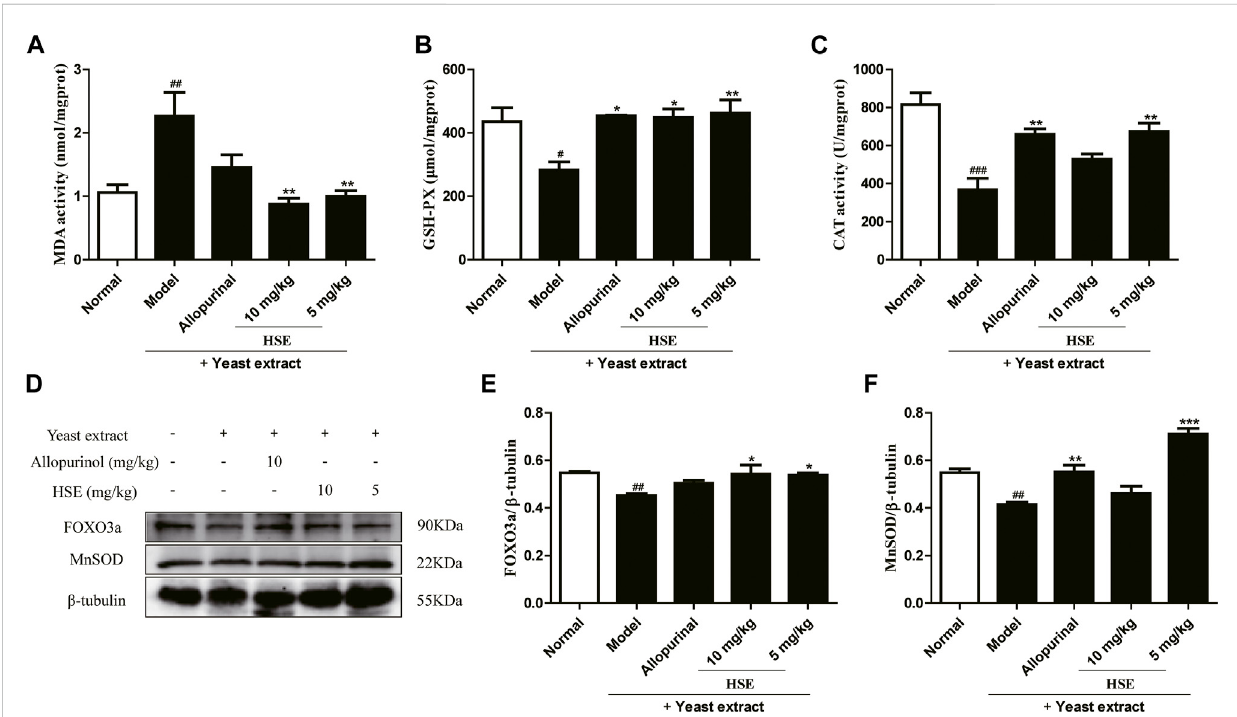
FIGURE 5 Effectsofhesperetin(HSE)onoxidativestressinmiceliverwithhyperuricemiainducedbyyeastextract. (A) MDAactivity (B) GSH-PX (C) CATactivity. Protein expression of FOXO3a (E) , MnSOD (F) , and β -tubulin were determined via Western blotting quanti fi ed with ImageJ. The dose of allopurinol was 10 mg/kg in vivo experiments. These data were from three separate experiments and expressed as the mean ± SEM. # p < 0.05, ## p < 0.01 and ### p < 0.001 versus the normal group; * p < 0.05, ** p < 0.01 and *** p < 0.001 versus the model group. HSE, hesperetin; MDA, malondialdehyde; CAT, catalase; GSH-PX, glutathione peroxidase; FOXO3a, forkhead box O3a; MnSOD, manganese superoxide